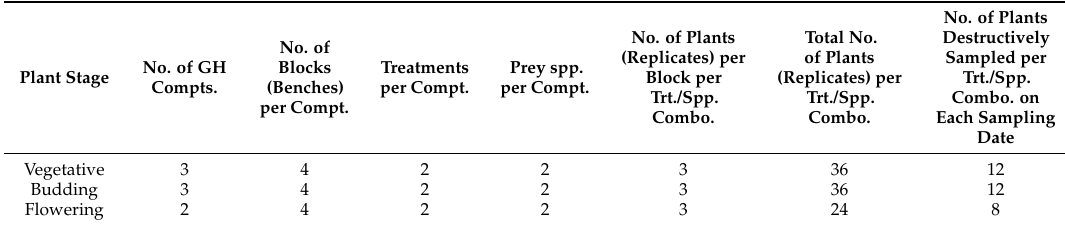
Table 1. Details of experimental set-up of plant growth-stage experiments in greenhouse (GH)